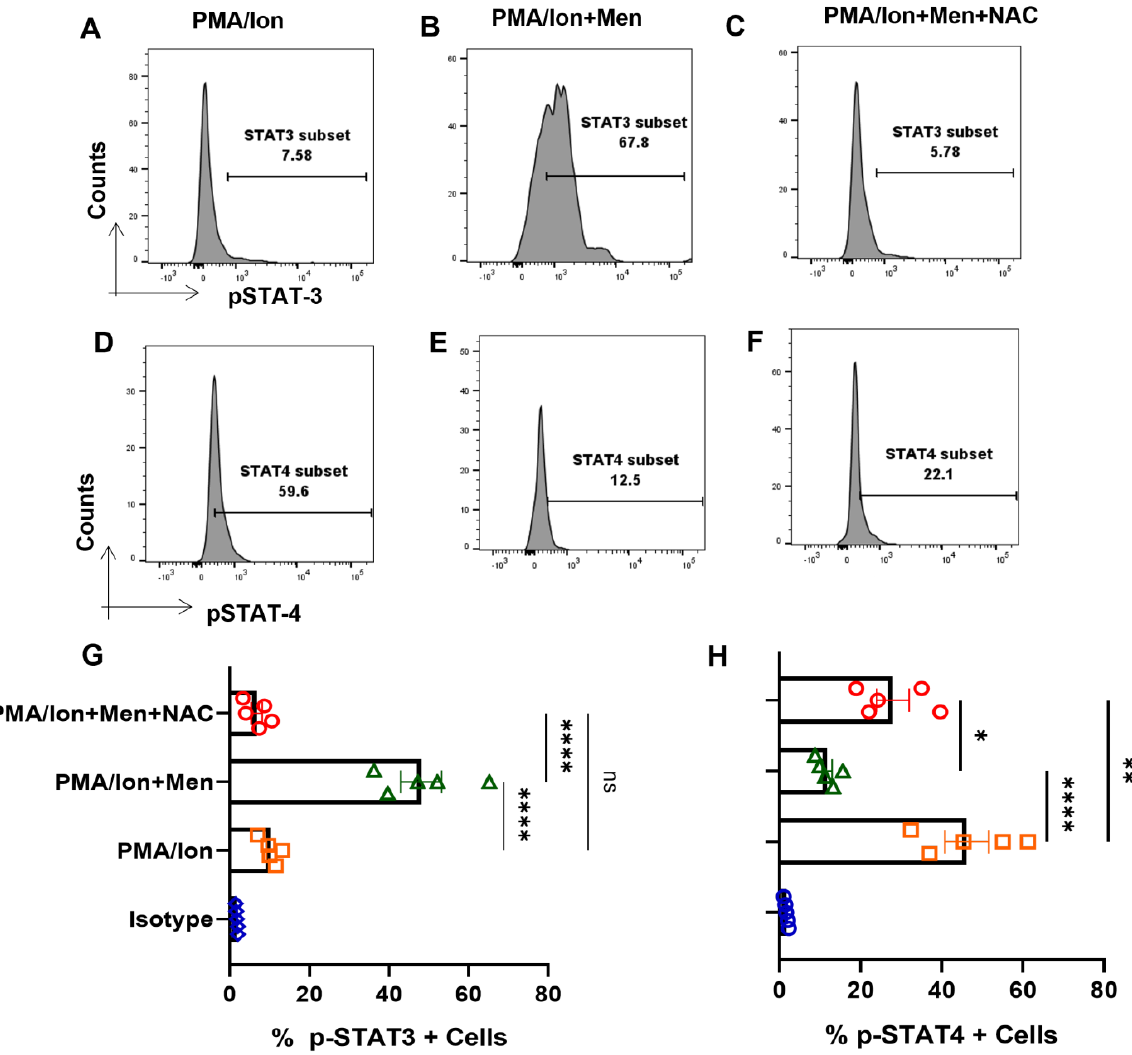
Figure 7. ROS modulates p −STAT’s from terminally differentiated Tc1 cells. Tc1 cells were